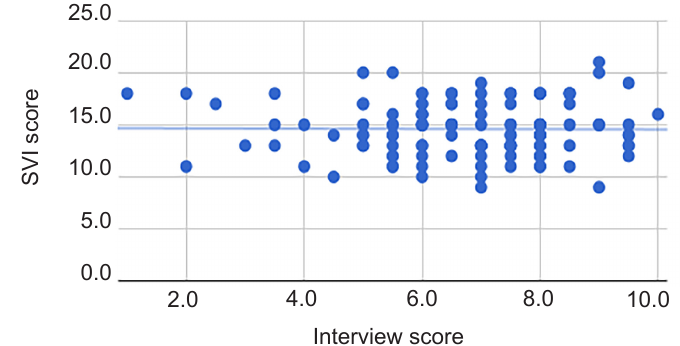
Figure 1. Scatter plot of transformed Standardized Video Interview (SVI) score vs. faculty gestalt score (r p=0.30), with line of best fit.